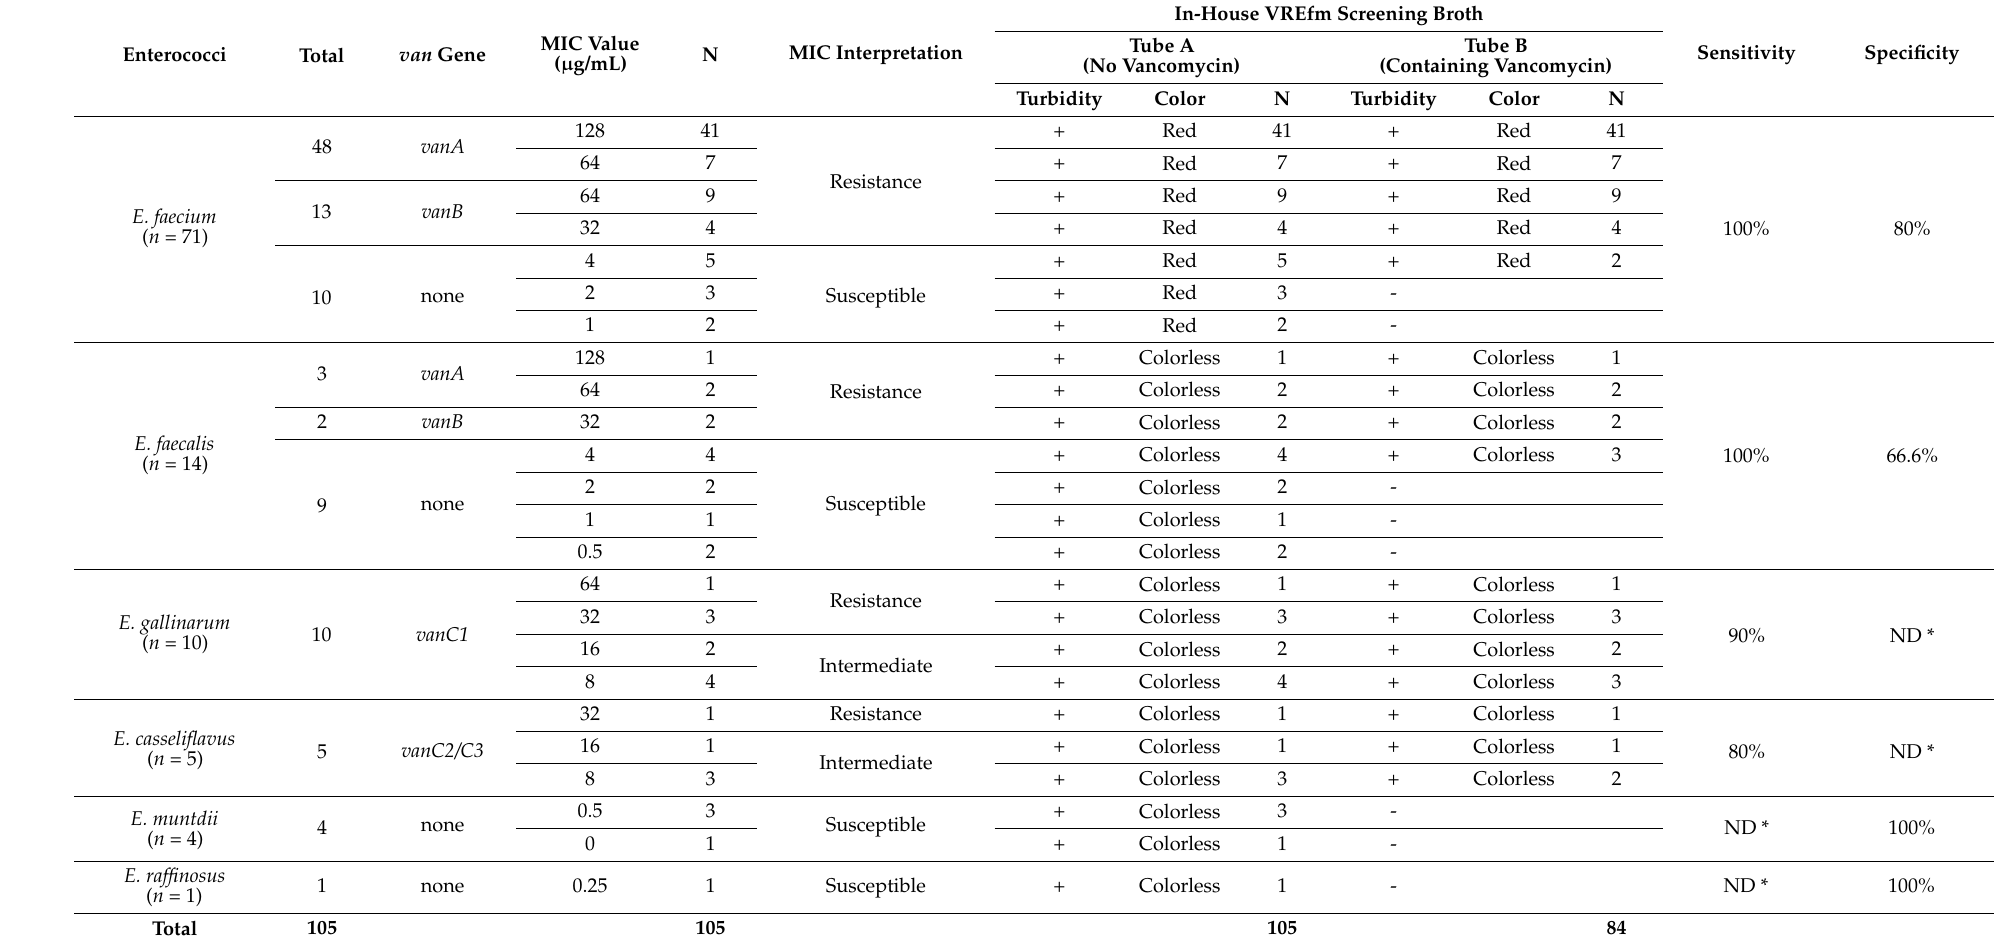
Table 1. Results of minimal inhibitory concentration by broth microdilution and in-house VREfm screening broth to susceptibility of vancomycin on 105 enterococci in this